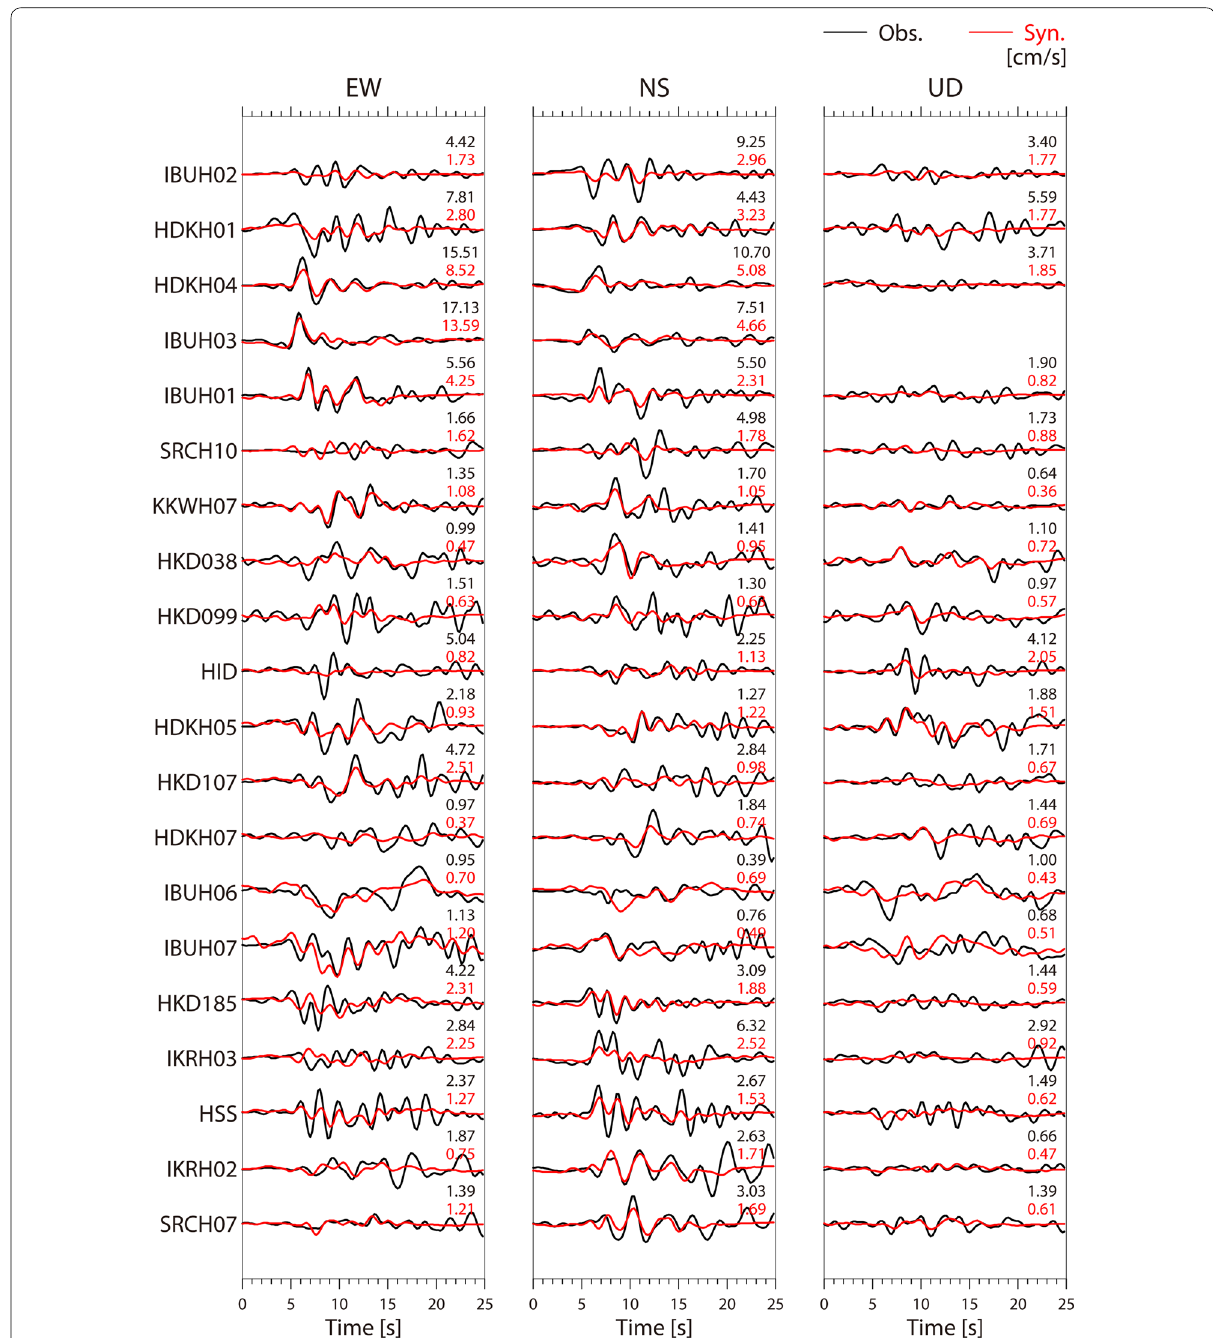
Fig. 3 Comparison of observed (black) and synthetic waveforms (red) in the source inversion. The number on the upper right-hand corner of each waveform denotes the maximum absolute amplitude in